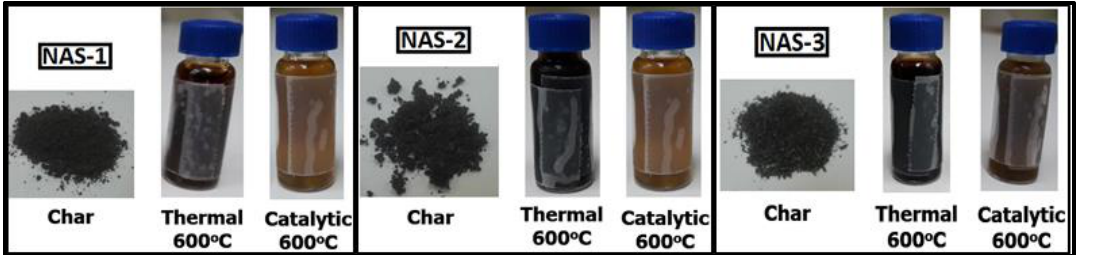
Figure 6. Char and pyrolysis oils obtained from the three solid organic wastes.